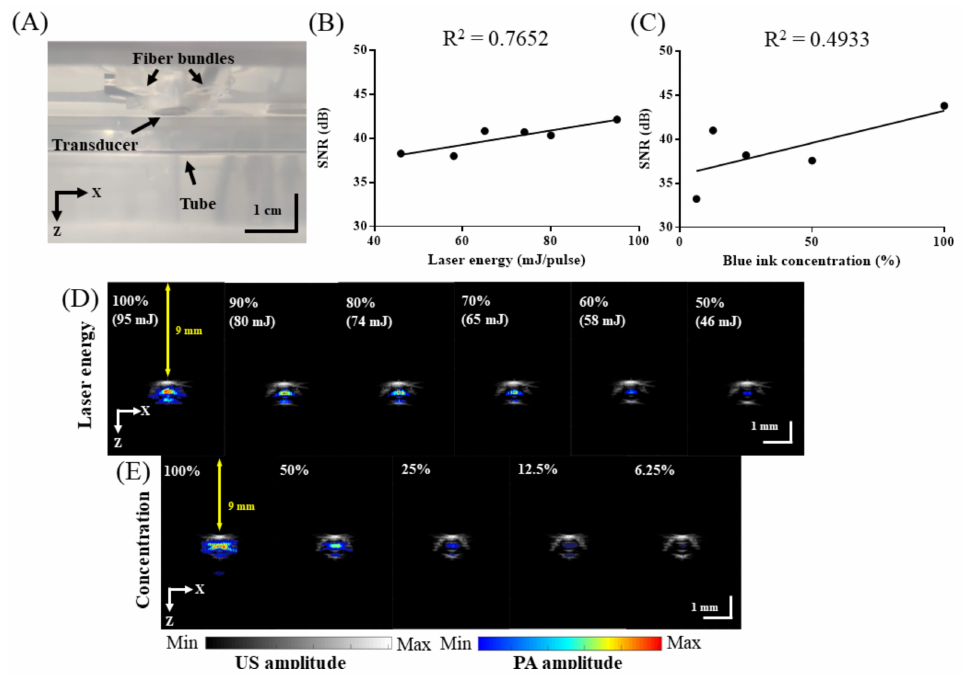
Figure 4. Testing of the in vitro imaging performance of our adjustable AR-PAM system. ( A ) Experi- mental setup in the water tank. ( B ) SNR of PA signals acquired while varying the energy of 750 nm wavelength excitation. ( C ) SNR of PA signals acquired while varying the blue ink concentration (100%, 50%, 25%, and 12.5% with saline). ( D ) Overlaid B-scan US/PA images corresponding to ( B ). ( E ) Overlaid B-scan US/PA images corresponding to ( C